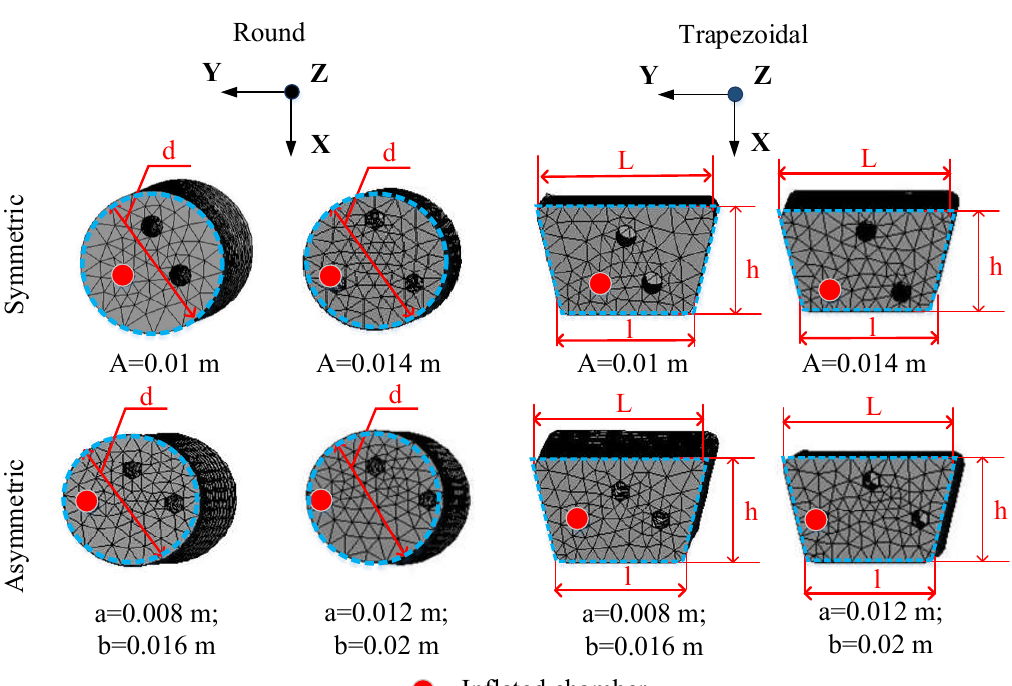
Figure 3. Top view showing the deformation results in ANSYS when a side chamber was inflated: Round cross-section with symmetrically located chambers, with chamber distance values of 0.01 m and 0.014 m ( A ) in the figure; round cross-section with asymmetric locations, with chamber distance values of 0.008 m, 0.016 m, 0.012 m, and 0.02 m ( a , b ) in the figure; trapezoidal cross-section with symmetrically located chambers, with chamber distance values of 0.01 m and 0.014 m ( A ) in the figure; trapezoidal cross-section with asymmetrically located chambers, with chamber distance values of 0.008 m, 0.016 m, 0.012 m, and 0.02 m ( a , b ) in the figure. The figure contains the base dimensions of each cross-section. All the round cross-sectioned models have a diameter of 0.026 m ( d ) and finger height of 0.12 m, while all the trapezoidal cross-sectioned fingers have a big base length of 0.035 m ( L ), a small base length of 0.025 m ( l ), and a leg length of 0.02 m ( h ). The deformation of each model is shown in the dark part and the dashed line represents the initial position of each finger.